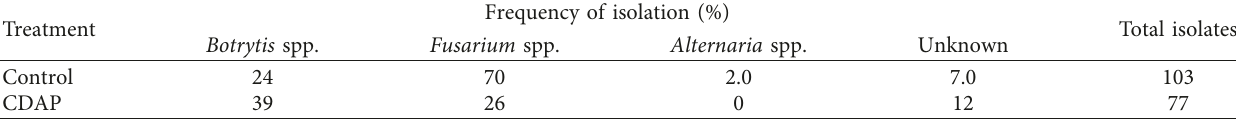
Table 2: Comparison of isolation frequency of fungi isolated from nontreated or CDAP-treated onions. Frequency of isolation (%) Treatment Botrytis spp.